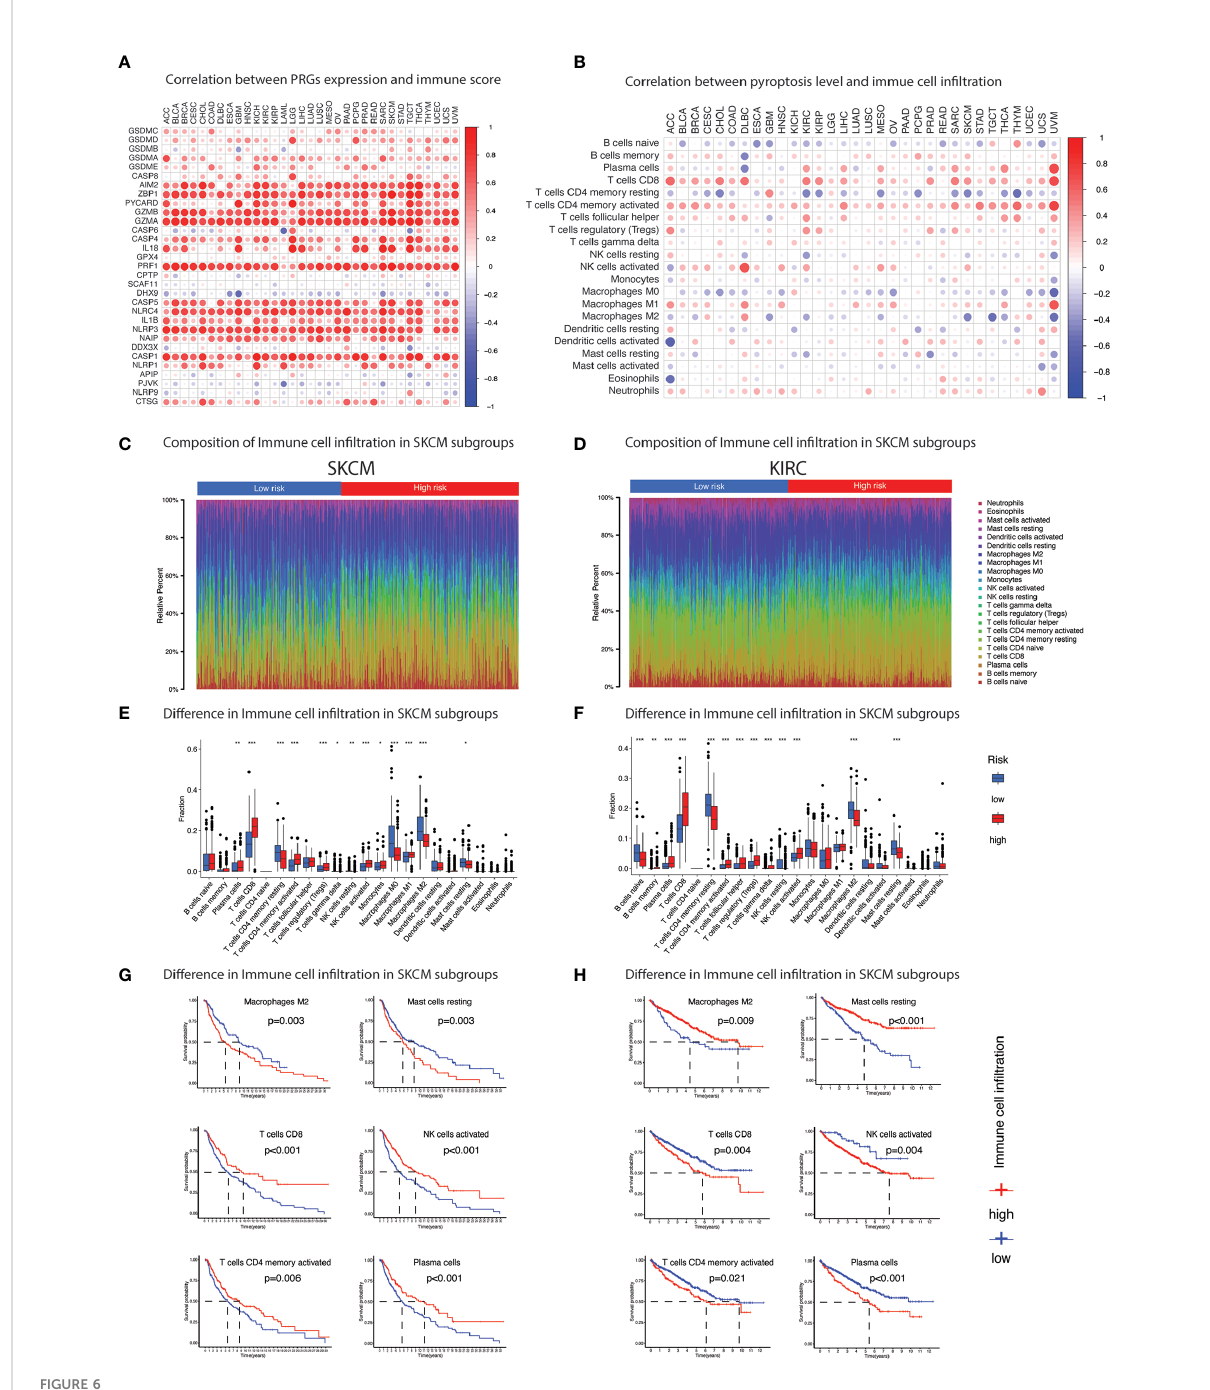
FIGURE 6 Immune cell in fi ltration. (A) Heatmap summarizes spearman correlation between pyroptosis level and ESTIMATE immune score. Red & blue indicate positive & negative correlation. (B) Heatmap summarizes spearman correlation between pyroptosis level and in fi ltration of 22 types of immune cells estimated by CIBERSORT algorithm. Red & blue indicate positive & negative correlation. (C-F) Pyroptosis subgroups (pyroptosis- low and pyroptosis-high) based on median pyroptosis level & proportions of TME cells in SKCM (C & E) and KIRC (D & F). The thick lines represent the median value. The bottom and top of the boxes are the 25th and 75th percentiles (interquartile range), respectively. Signi fi cant statistical differences between the two subgroups were assessed using the Wilcoxon test. * p value < 0.05; ** p value < 0.01; *** p value < 0.001; ( p value > 0.05). (G) Kaplan-Meier curves of survival analysis of immune cells in SKCM and (H) KIRC based on the in fi ltration